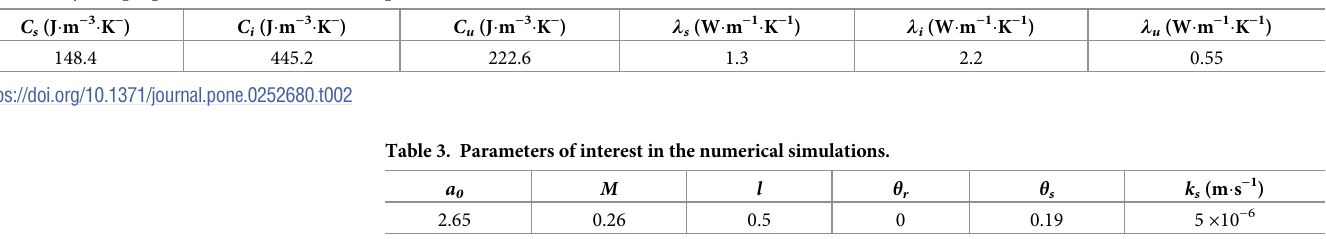
Table 2. Physical properties of the tested soil sample.